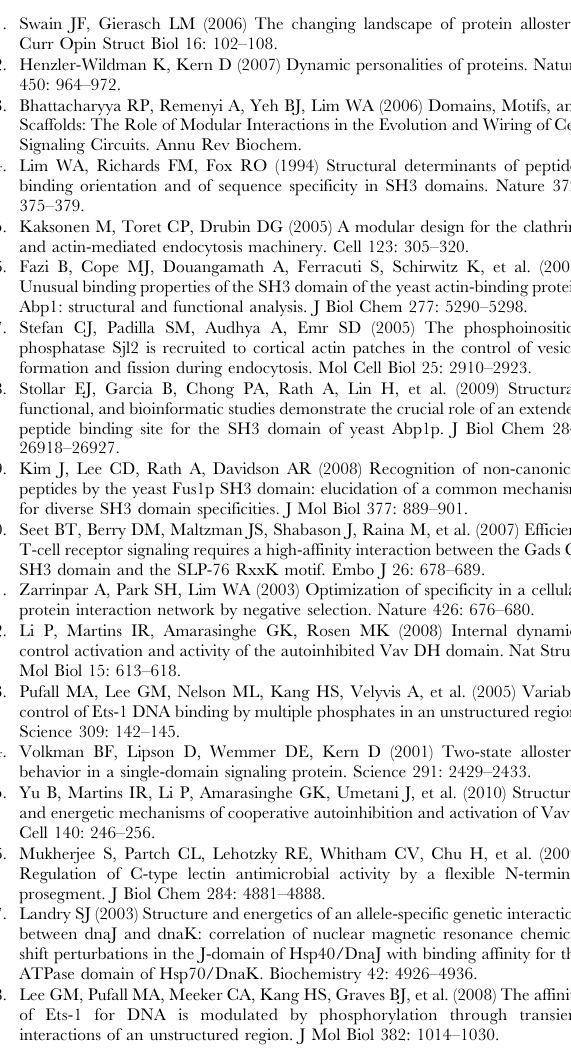
changes and with much smaller magnitude compared to SII. Table S2 CCSP values for all residues analyzed further in this study. As mentioned in Table S1, several SI-associated residue values are missing due to the fact that chemical shift changes were much smaller in this region compared to SII which allows for greater contamination effects. Residue numbers followed by ‘‘s’’ refer to the side-chain NH group. Table S3 Alignment of sequences used in this study. Residues in bold are mutation sites. The sequences are ordered according to their average CCSP values in SII. Table S4 Parameters for binding of the 24 studied peptides to the AbpSH3. The sequences are ordered according to their average SII CCSP value. Binding data for peptides not in bold were reported in ( 8 ). Errors are 6 95% confidence intervals except D C P values which report the standard error of the least squared fit to the data ( D H vs. temperature). PRR1 is a 15-residue peptide found N-terminal to AbpSH3 (residues 516 to 530